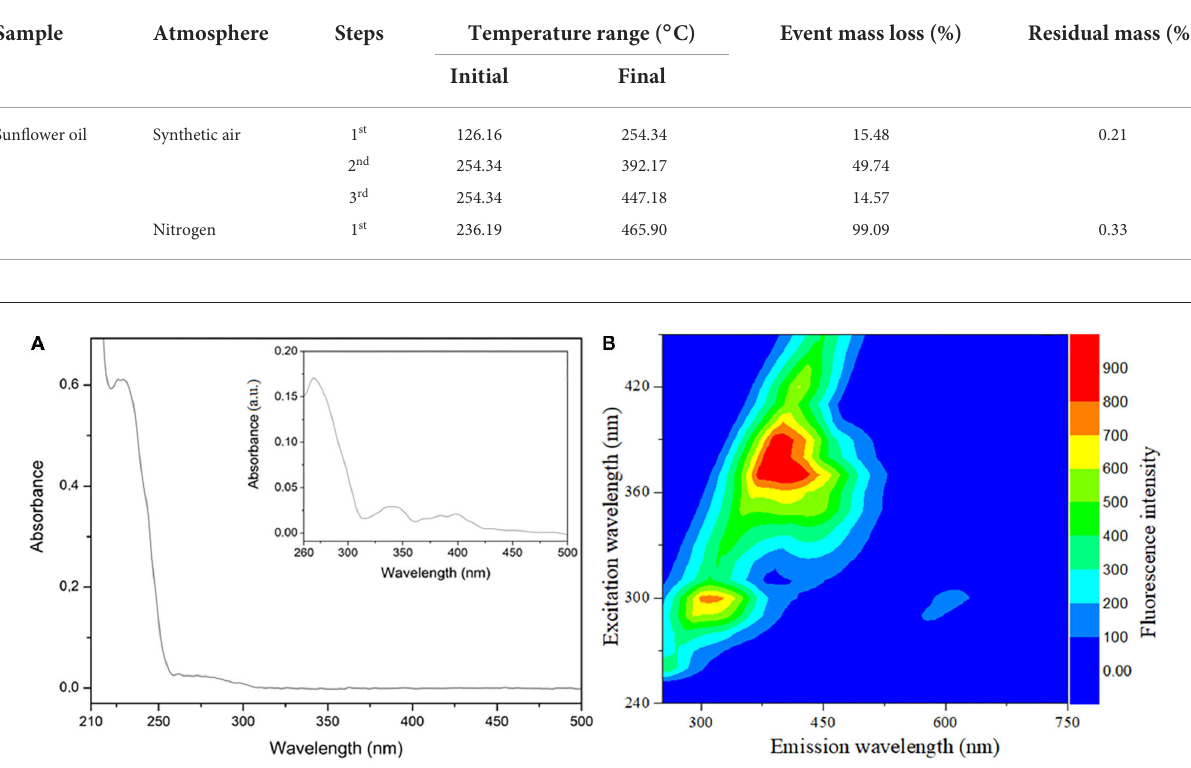
FIGURE3 Optical molecular analysis used sunflower oil diluted in hexane HPLC 99.9% at 1 × 10 − 3 g L − 1 . (A) UV-Visible absorption spectrum wavelength collected between 200 and 800nm and the inset “zoom”; (B) Emission-excitation fluorescence spectrum map with excitation obtained between 240 and 450nm and emission